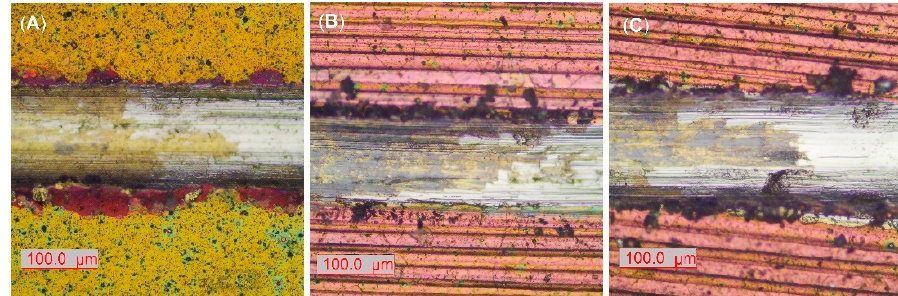
Figure 9. Representative micrographs of scratch tracks at adhesive critical loads (Lc) of ( A ) А R; ( B ) AR850; ( C ) AR500 samples.